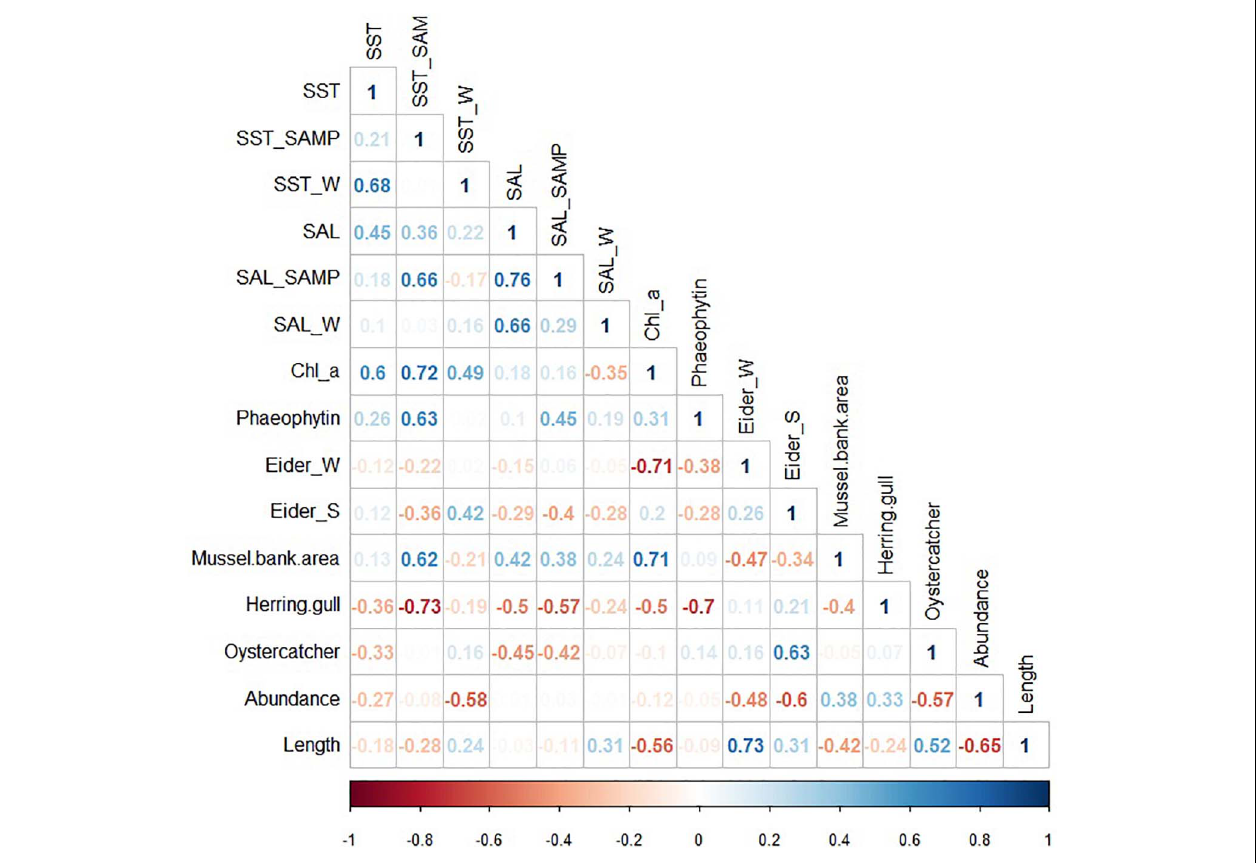
FIGURE 6 | Spearman correlations coefficients between environmental parameters and biological data. SST, mean annual sea surface temperature anomaly; SST_SAMP, mean annual sea surface temperature anomaly during sampling; SST_W, mean annual sea surface temperature anomaly in winter; SAL, mean annual salinity anomaly; SAL_SAMP, mean annual salinity anomaly during sampling; SAL_W, mean annual salinity anomaly in winter; Chl_a, chlorophyll a; Eider_W, abundances of common eider in winter; Eider_S, abundances of common eider in summer; Mussel bed, mussel bed area; Herring Gull, abundances of herring gulls at Mellum; Oystercatcher, oystercatcher abundances; Abundance, mean cockle abundance; Length, mean cockle